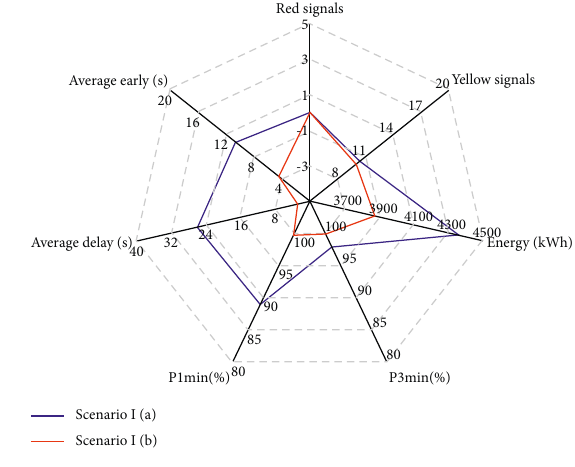
Figure 4: Results of Scenario I.